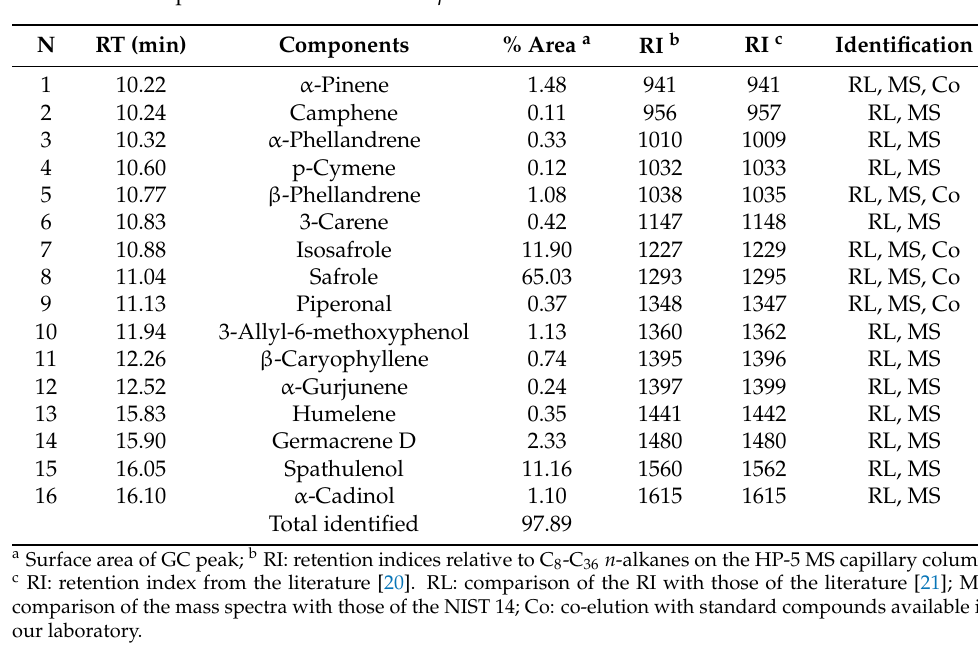
Table 1. EO composition of leaves of L. sempervirens .